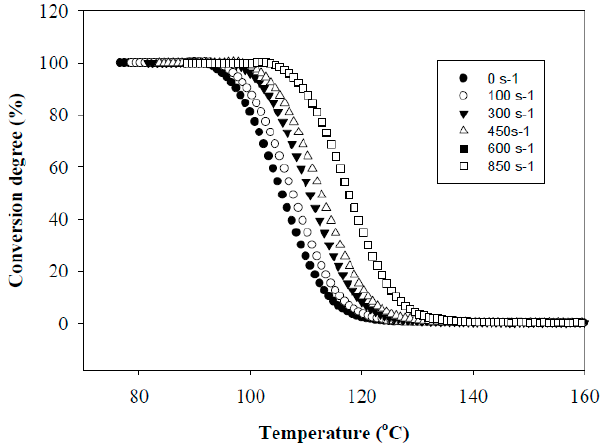
Figure 2. Dependencies of conversion degree of PHA during cooling with pre-crystallization shearing.